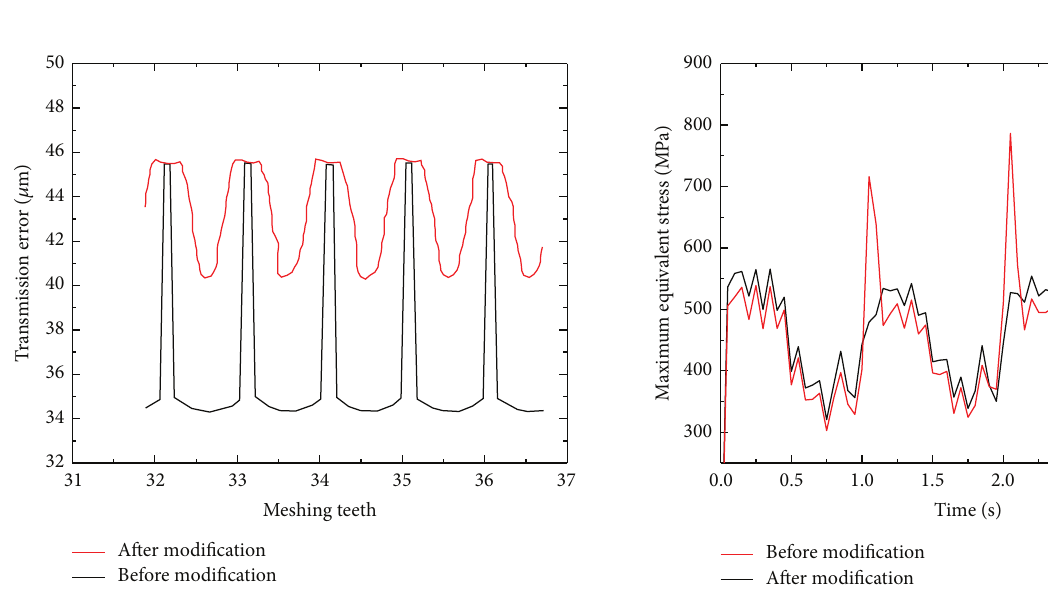
Figure 6: Comparison of effective stress computed by MASTA software before and after gear modification.